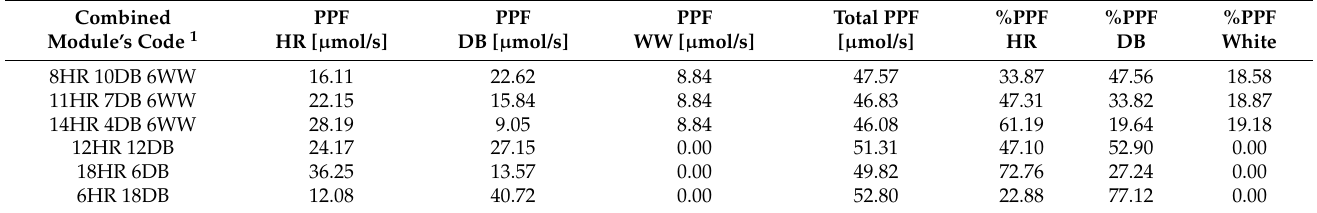
Table 2. Calculation of the PPF for each considered module